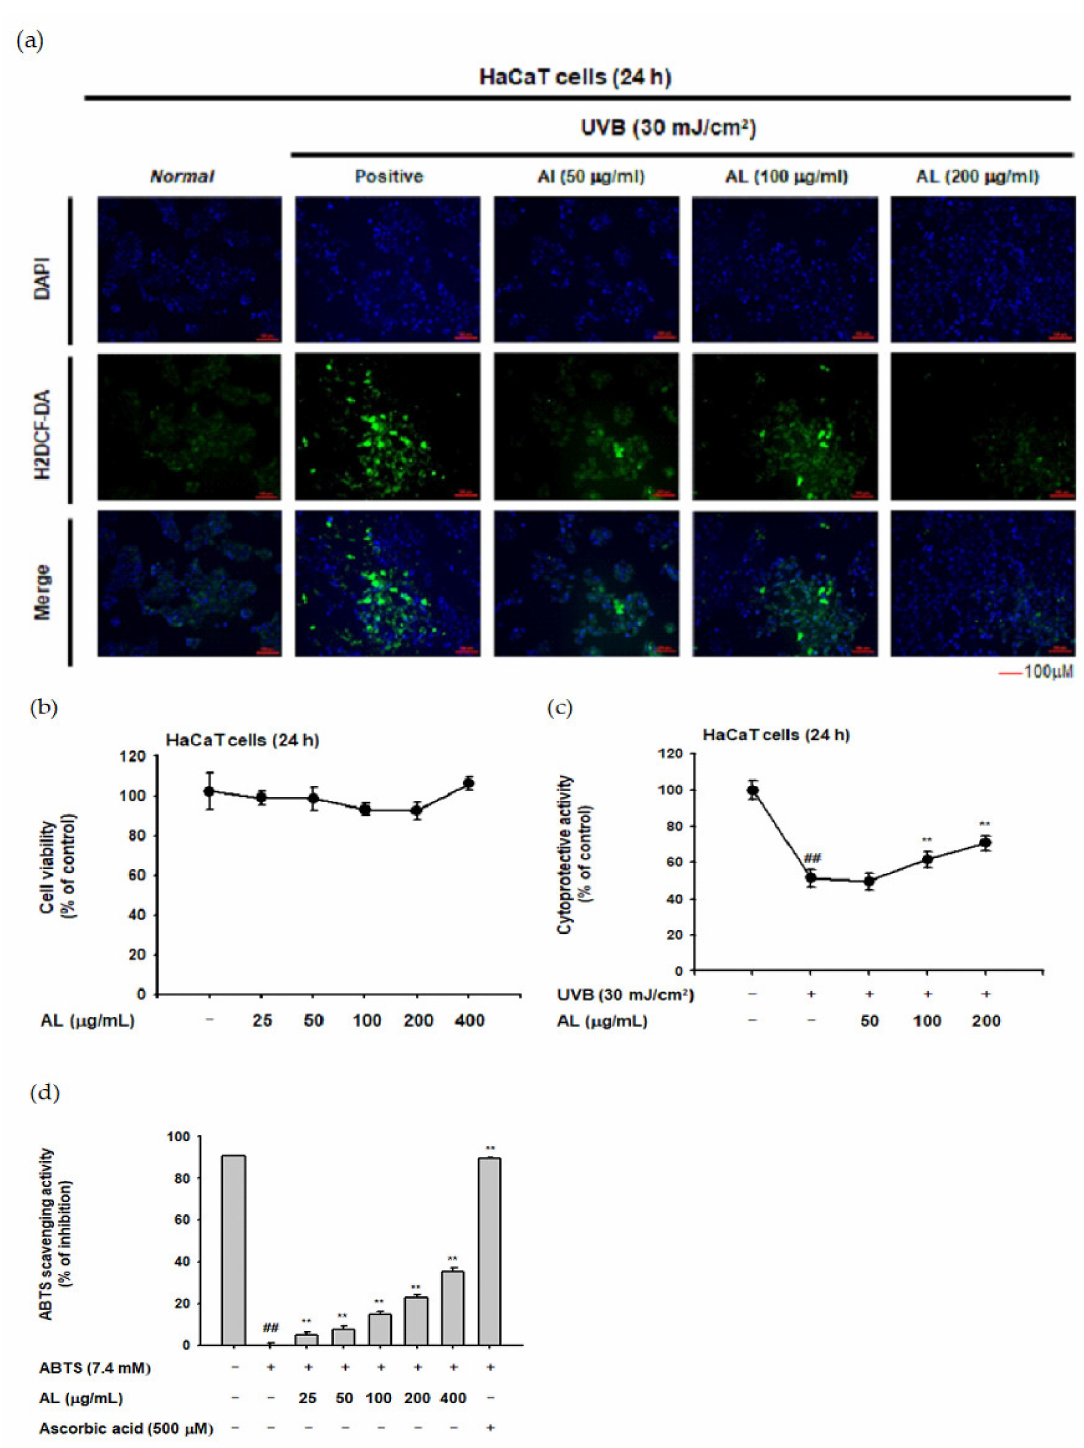
Figure 1. In vitro skin antioxidant e ff ects of tyndallized Lactobacillus acidophilus (AL). ( a ) Primary human keratinocyte (HaCaT) cells were subjected to ultraviolet-B (UVB) irradiation (30 mJ / cm 2 ) in the absence or presence of AL (50–200 µ g / mL), and the resulting reactive oxygen species (ROS) levels were determined with a H2DCFDA staining assay. ( b ) Cell viability of HaCaT cells treated with the indicated dose of AL (50–200 µ g / mL) for 24 h was measured using the tetrazolium